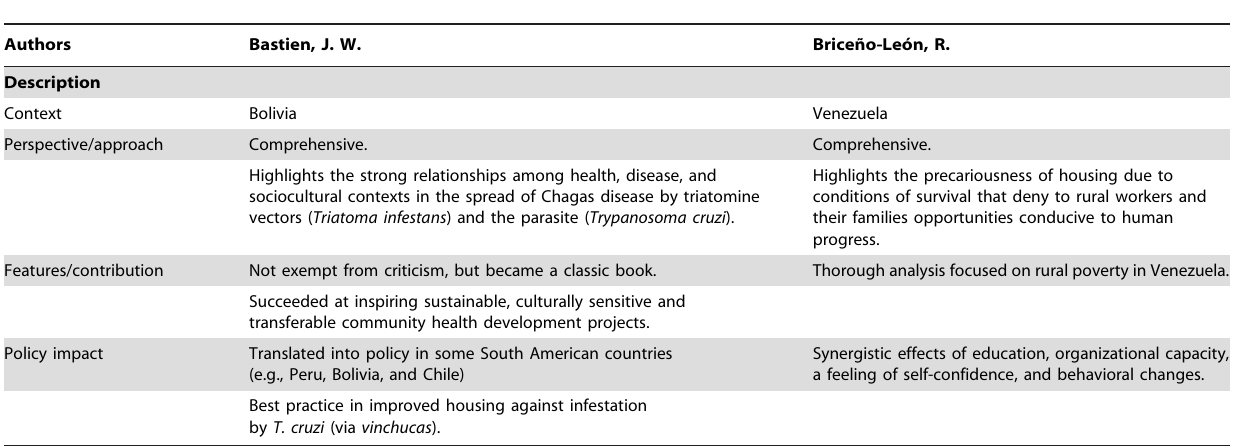
Table 1. An illustration of social scientists’ work on Chagas disease in South America.